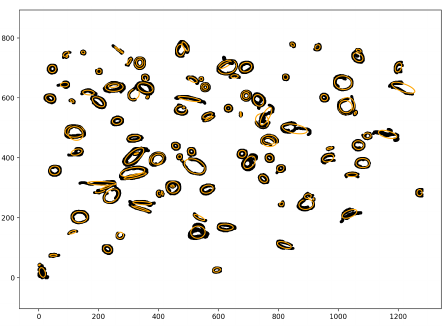
Figure 9. Fitted ellipses and obtained clusters of edges: as clearly seen most clusters are determined correctly with a certain number of false bubbles detected which might be caused by double edges produced by the edge detection method described